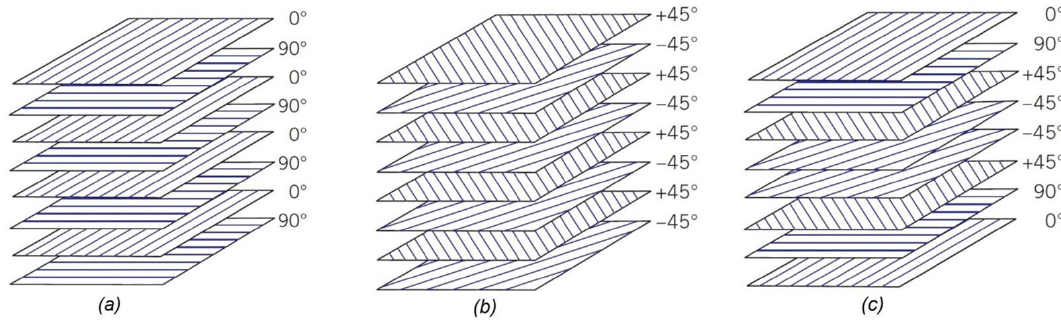
Figure 3. Composite laminated lay-ups. ( a ) Cross-ply, ( b ) angle-ply, and ( c ) multidirectional (0°, 90°, and ±45°). Table 3. Engineering properties of facing material construction [49].